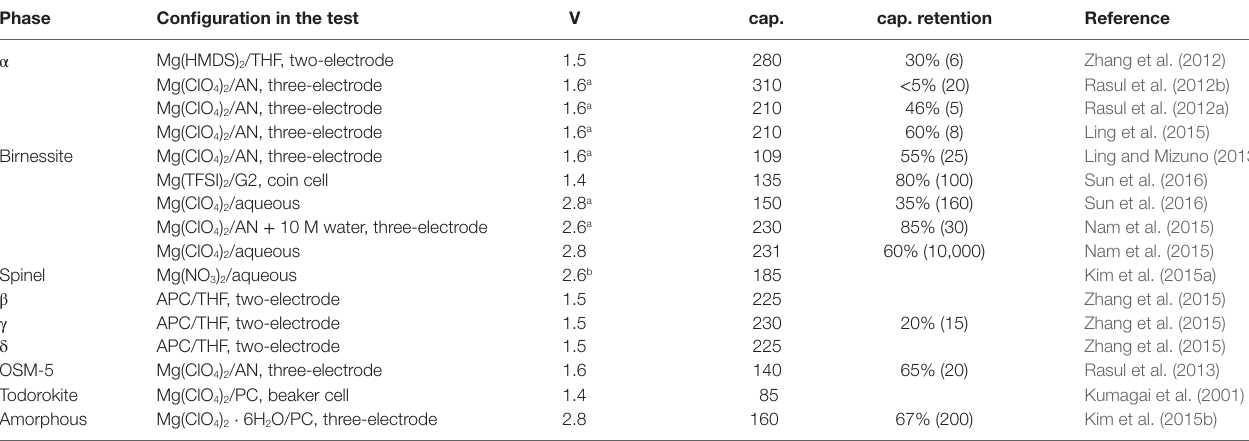
TABLe 1 | Summary of average discharge voltage, highest discharge capacity (cap.), and capacity retention for MnO 2 in different magnesium cell configurations. Phase Configuration in the test cap.